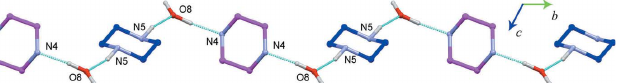
Figure 2 Superimposition of DNSA 2 (cid:2) units in (I) and its analogs [colour codes: EGUVAD (green), ROFLIJ (blue), ZONBIP (red) and XEBFAM (magenta)].